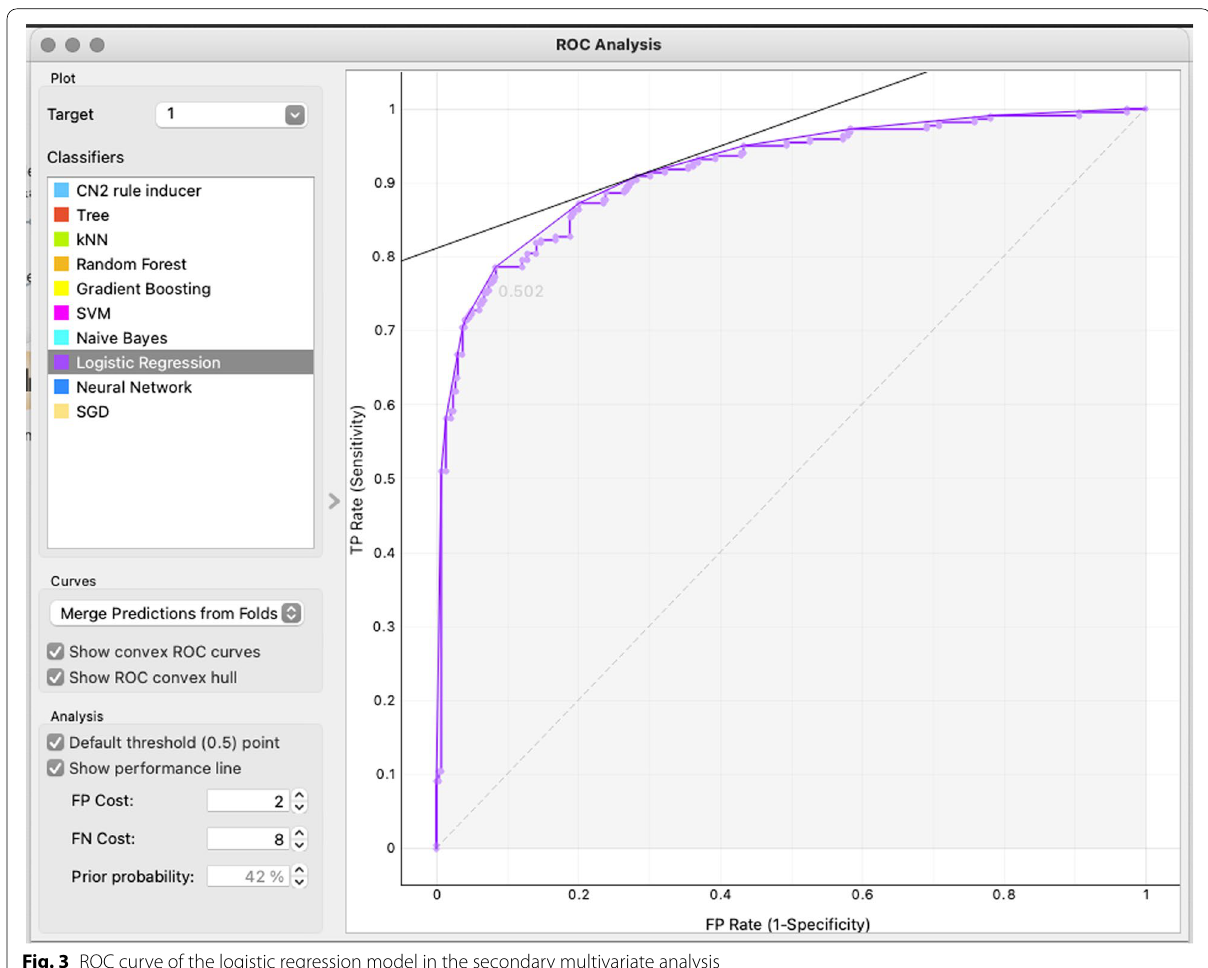
Fig. 3 ROC curve of the logistic regression model in the secondary multivariate analysis